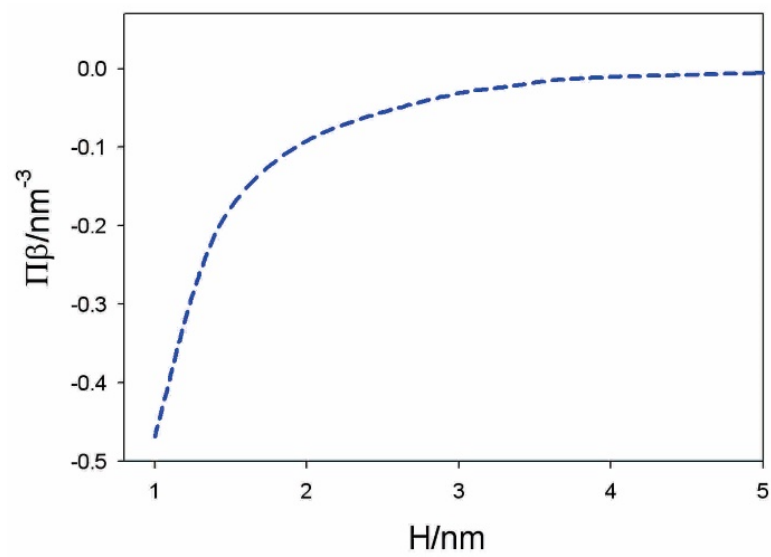
Figure 10. Calculated osmotic pressure between the dipolar headgroups and planar negatively charged surface as a function of the distance between the plane of the lipid phosphate groups and the charged surface (H) for alpha = 5. The values of model parameters are: T = 298 K, σ 1 = –0.30 As/m 2 , σ 2 = 0.30 As/m 2 , dipole moment of water p 0 = 3.1 Debye, bulk concentration of salt n 0 / N A = 0.01 mol/L, and concentration of water n w / N A = 55 mol/L. Reprinted from [38] with permission from Elsevier.